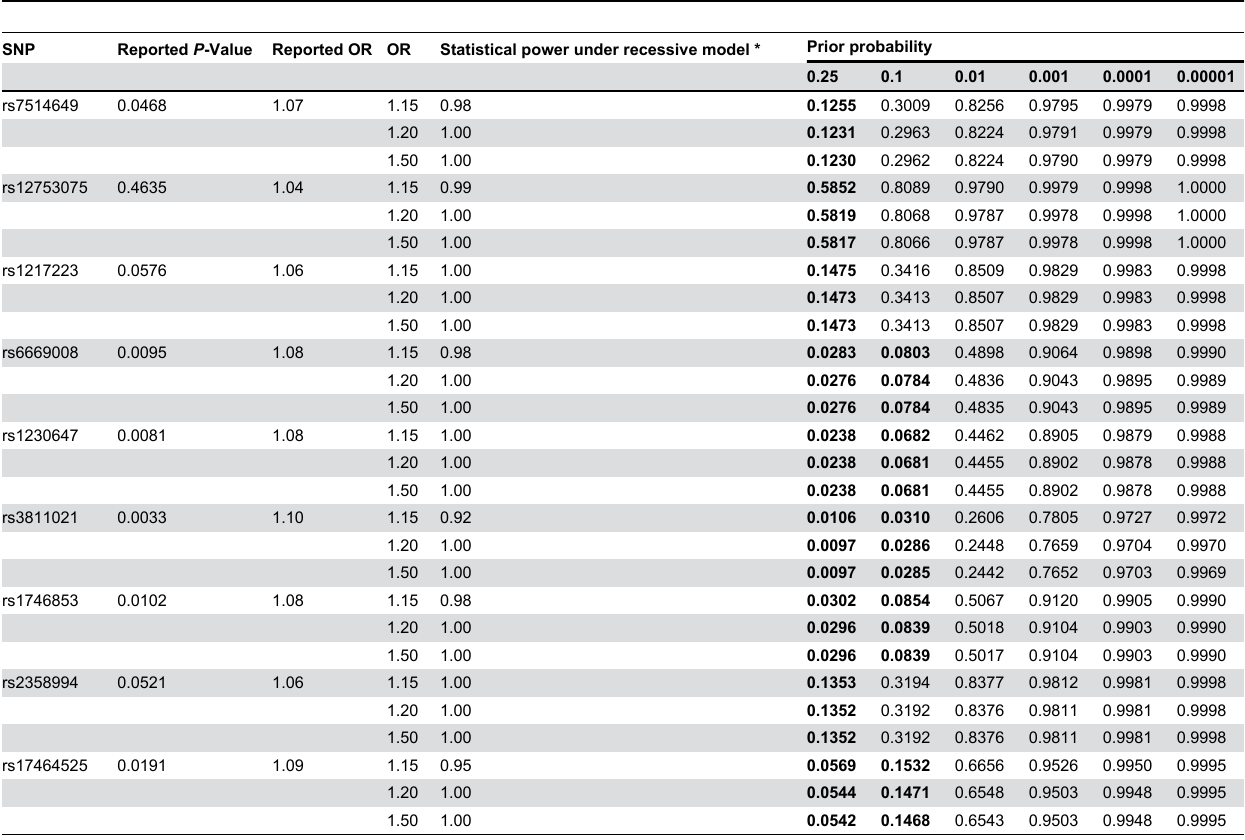
Table 2. False positive report probability (FPRP) values for nine replicated SNPs between 5,696 GD patients and 5,767 health